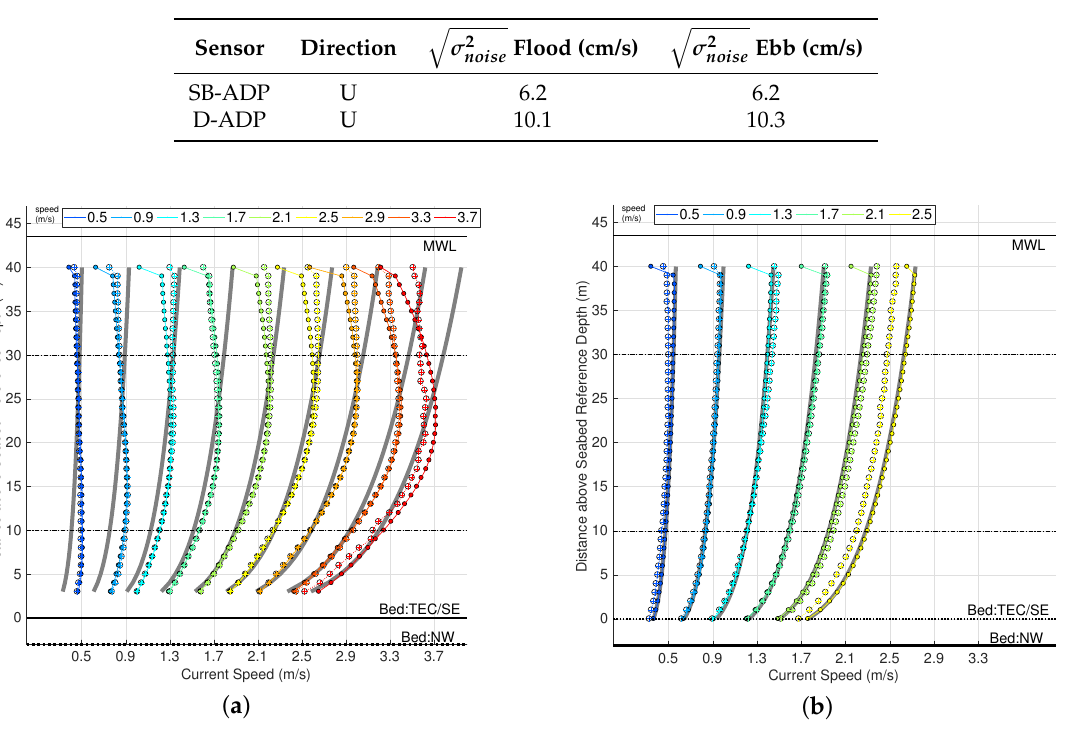
Figure 5. Depth profiles of streamwise velocity for ( a ) ebb and ( b ) flood tide. Solid grey lines show power-law fit ( α = 7). Small filled circles and large open circles with a centred cross show flows in the absence and presence of waves, respectively. Data is binned by speed as per the top horizontal legend. MWL shows mean water level. SE and NW indicate depths at southeast and northwest